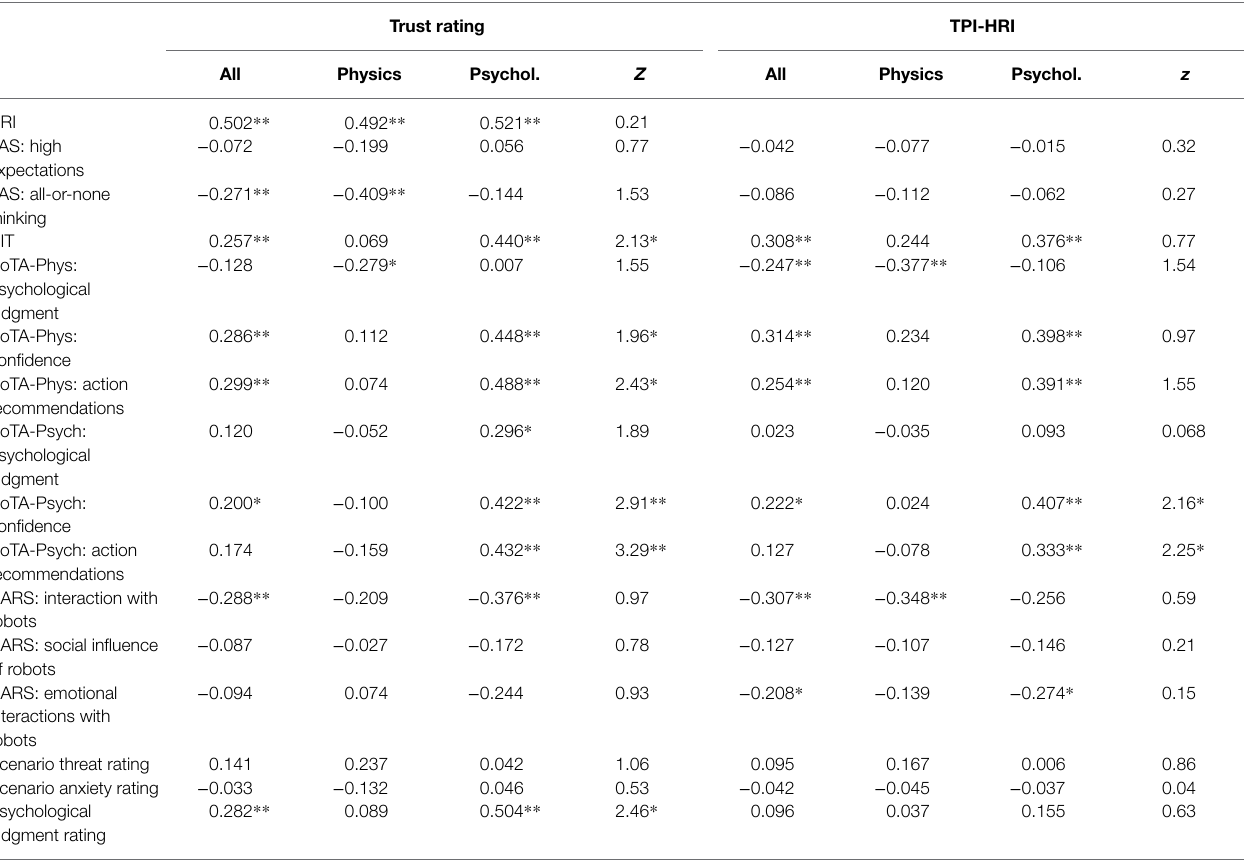
TABLE 4 | Correlates of two situational trust measures, overall and by analysis mode. Trust rating